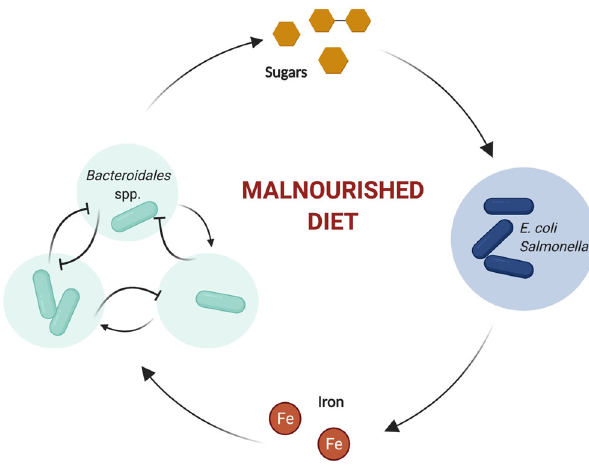
Fig. 6 Schematic of the metabolic network between Bacteroidales and Enterobacteriaceae . In the context of a carbohydrate-rich, protein-de fi cient malnourished diet, Bacteroidales spp. cooperatively liberate sugars. Enterobacteriaceae members consume these sugars and provide iron to Bacteroidales . Together these interactions constitute a feedback loop leading to enhanced growth of both Enterobacteriaceae and Bacteroidales . These taxonomic groups contain notable pathogens, including S. enterica , enteroaggregative E. coli , and enterotoxin-producing B. fragilis , which may adversely affect intestinal